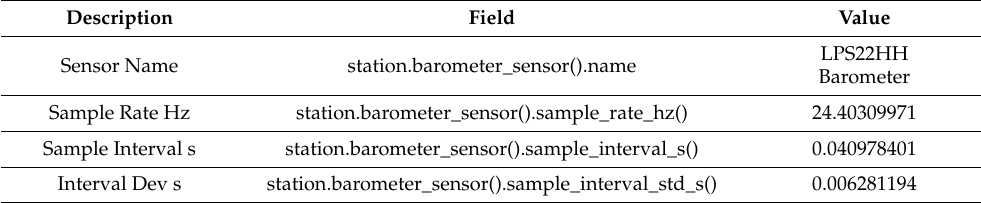
Table 6. Barometer Sensor.